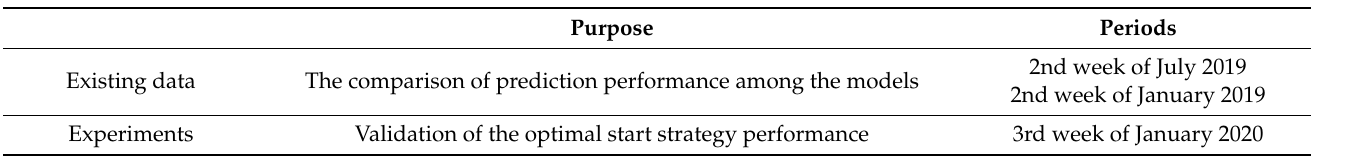
Table 1. Existing data and experiments.